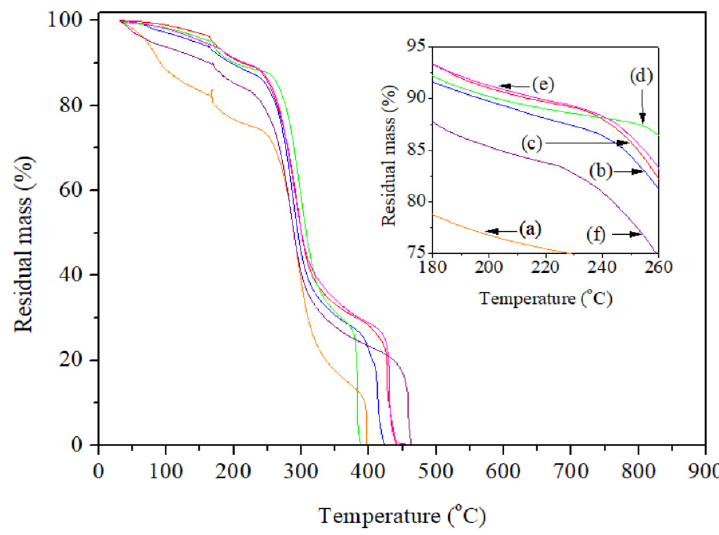
Figure 5. TGA curves from the di ff erent spaghe tt i-type pasta systems studied: ( a ) NSt, ( b ) NSt + Bu, ( c ) NSt + Bu + TAc, ( d ) OSt, ( e ) OSt + Bu and ( f ) OSt + Bu + TAc. ( c ) NSt + Bu + TAc, ( d ) OSt, ( e ) OSt + Bu and ( f ) OSt + Bu +